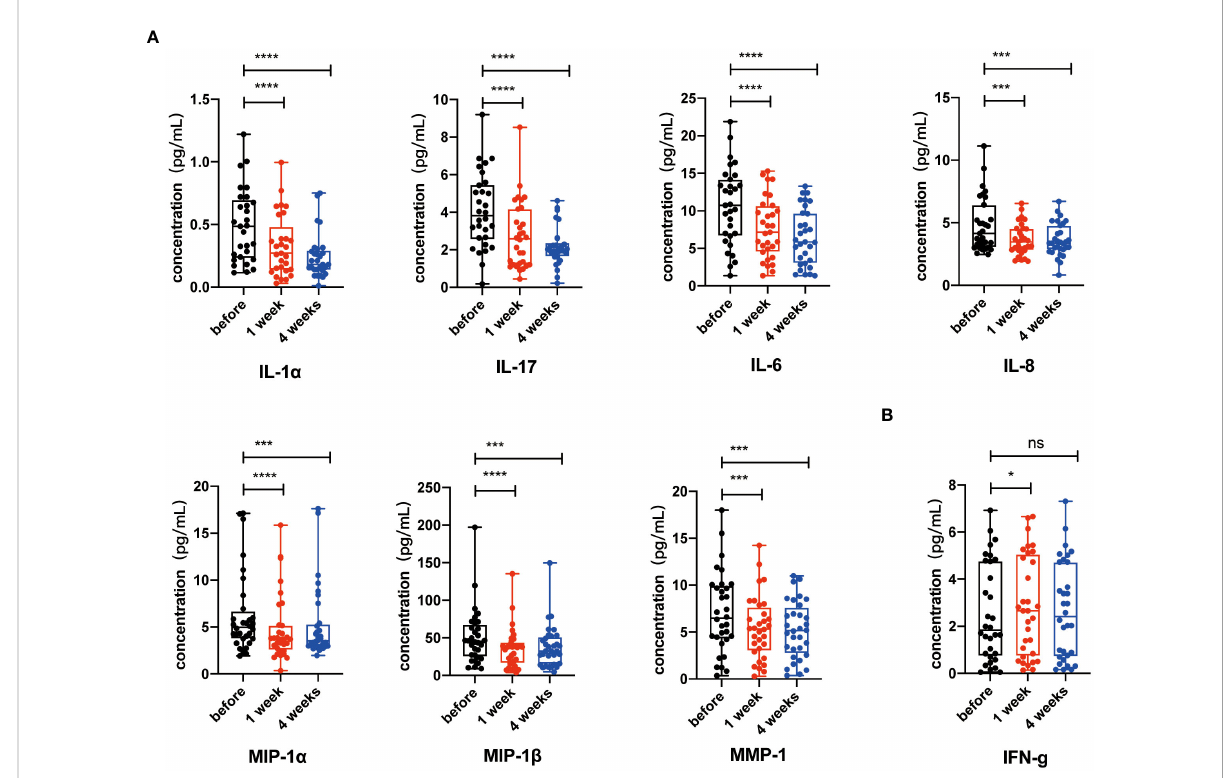
FIGURE 5 Key senescence-associated secretory phenotype (SASP) components decreased after NK cell infusion. (A) IL-6, IL-8, IL-1 a , IL-17, MIP-1 a , MIP- 1 b , and MMP1 were detected by Luminex xMAP technology on the 1 week and 4 weeks after NK cell infusion. (B) IFN- g were detected by Luminex xMAP technology on the 1 week and 4 weeks after NK cell infusion. Data [IL-6 ( n = 31), IL-8 ( n = 31), IL-1 a ( n = 29), IL-17 ( n = 30), MIP-1 a ( n = 32), MIP-1 b ( n = 32), MMP1 ( n = 32), and IFN- g ( n = 32)] were analyzed by paired t -test. * p < 0.05; *** p < 0.001; **** p <